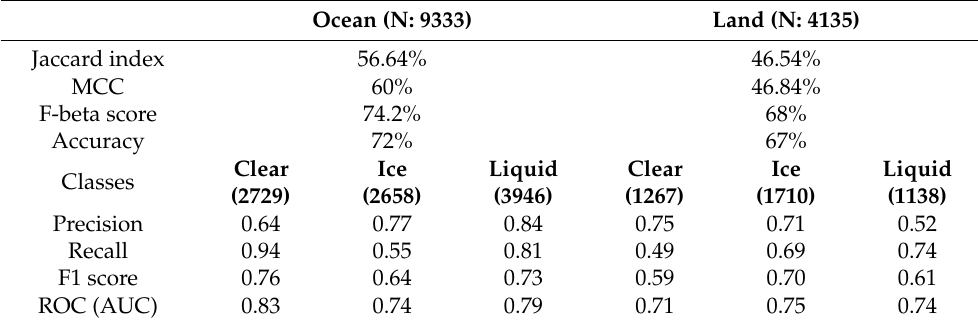
Figure 10. Confusion matrices for clear, ice and liquid predictions by NN models over the ocean ( left ) and over land ( right ) using the measured AMSU-A/MHS dataset. The lighter boxes represent the number of pixels correctly classified for each of the classes, while the darker boxes represent misclassifications. Table 6. Evaluation metrics of the cloud detection neural network trained with a simulated dataset for AMSU-A/MHS sensors and validated with